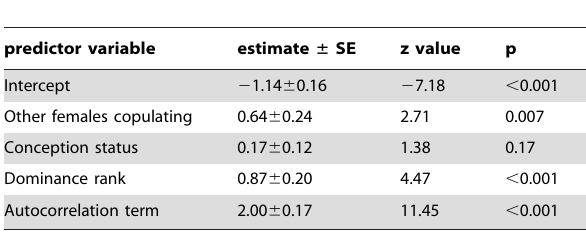
Table 1. Factors influencing the probability of a given female to copulate on a given day (binary